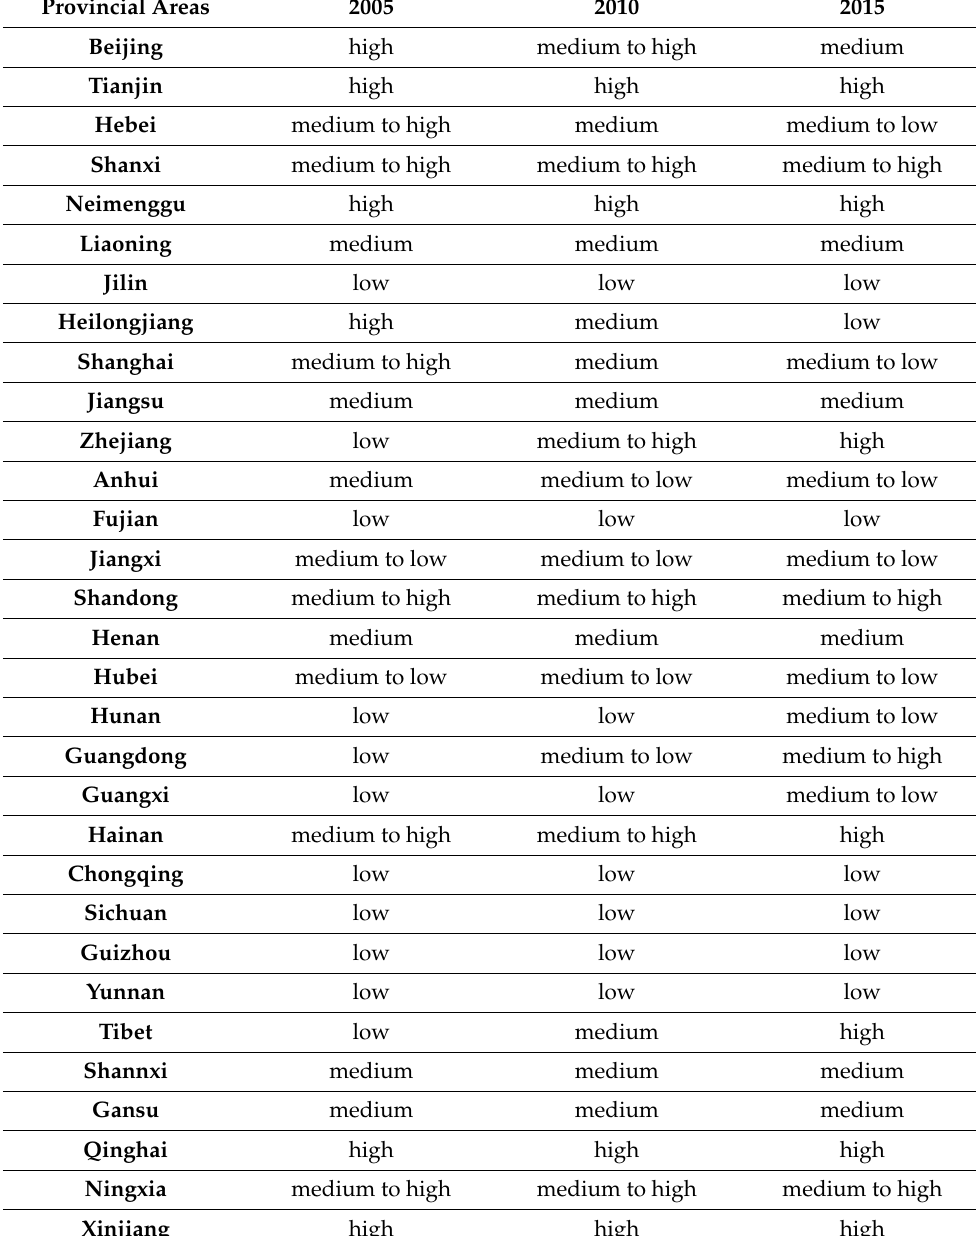
Table 5. Corresponding gray cluster results of the agricultural mechanization development level of the provincial areas in the three